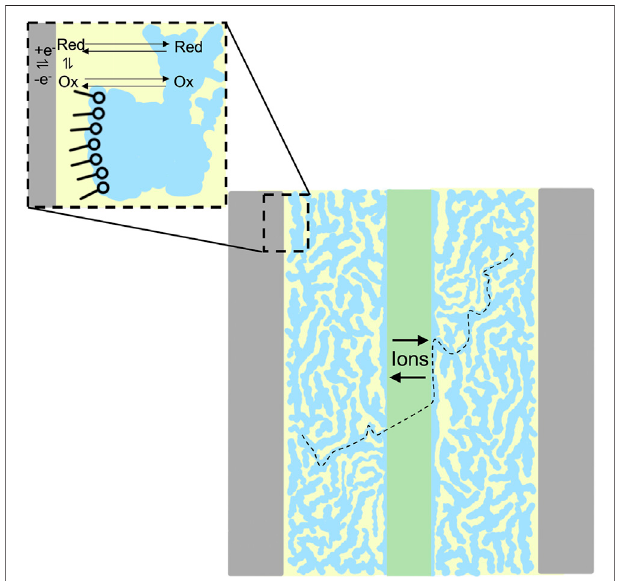
SCHEME 1 | An illustration of a redox fl ow battery with bicontinuous microemulsion electrolytes comprised of water (blue) and oil (yellow) phases separated by surfactant (inset). Ion conduction (black dashed line) is depicted throughtheaqueousphaseandmembrane.Redoxreactionsareshown in the oil phase (inset).